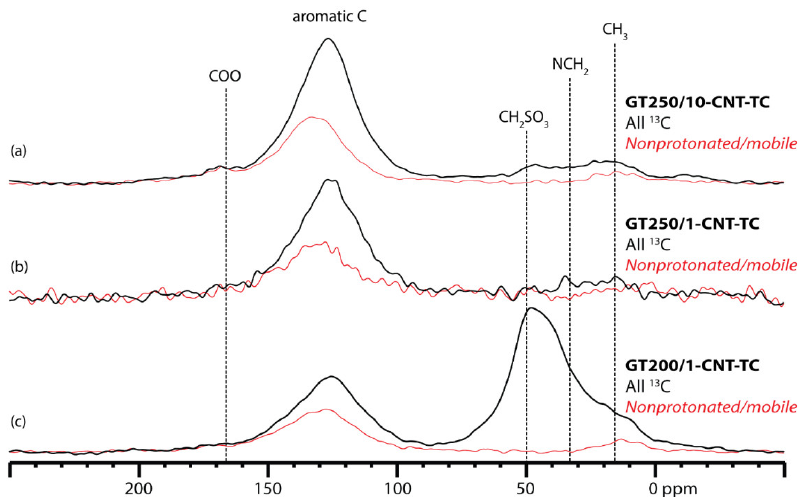
Figure 5. MultiCP 13 C NMR spectra of 13 C-taurine-labeled glucose-taurine pyrolysis products, all